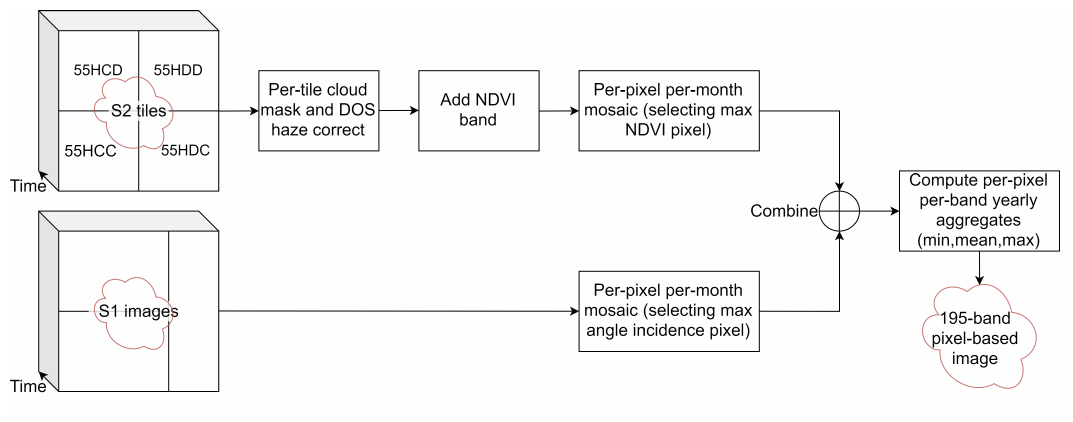
Figure 2. S1 and S2 image preprocessing